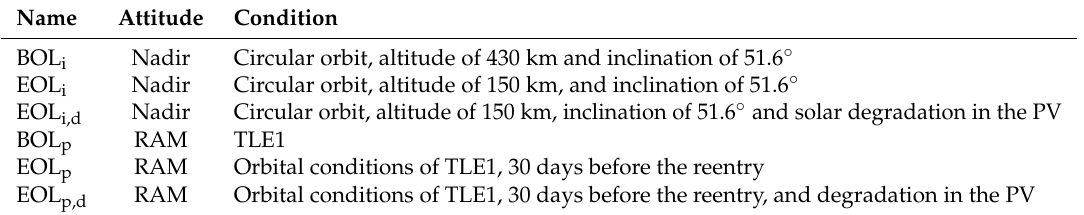
Table 4. Scenarios for power